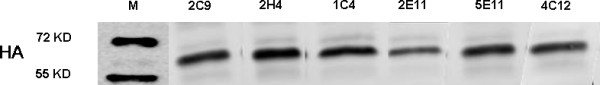
Reactivity of the Mabs to the HA protein of virus dw/04. Due to the different Mabs were used to perform the western blot, the six reactions were performed separately and the image was resembled together. Same HA protein loading and exposure time were used in the western blot assay.